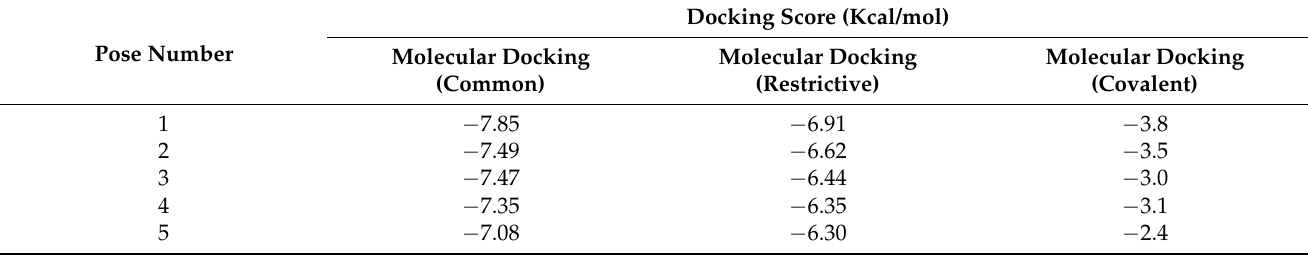
Table 3. Docking scores for the top five poses of the common, restricted, and covalent docking results of pS273R with E64